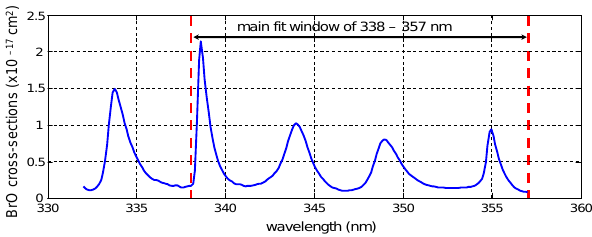
Fig. 6. BrO absorption cross-section (Fleischmann et al. (2004)) used for simulations of spectra, convoluted to SCIAMACHY reso- lution of FWHM of 0.21nm. In the main settings the fit window from 338–357nm is applied (indicated by red lines in the plot). For the sensitivity studies, different fit windows containing 2–5BrO ab- sorption peaks within the wavelength region from 332–357nm are